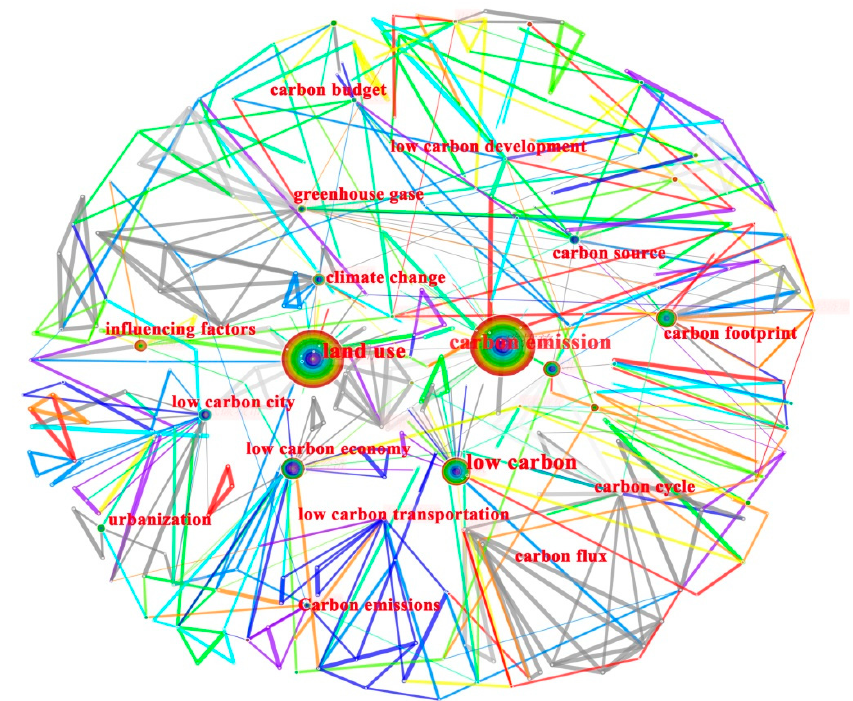
Figure 8. Co-occurrence graph of keywords for carbon emissions research in the CNKI database